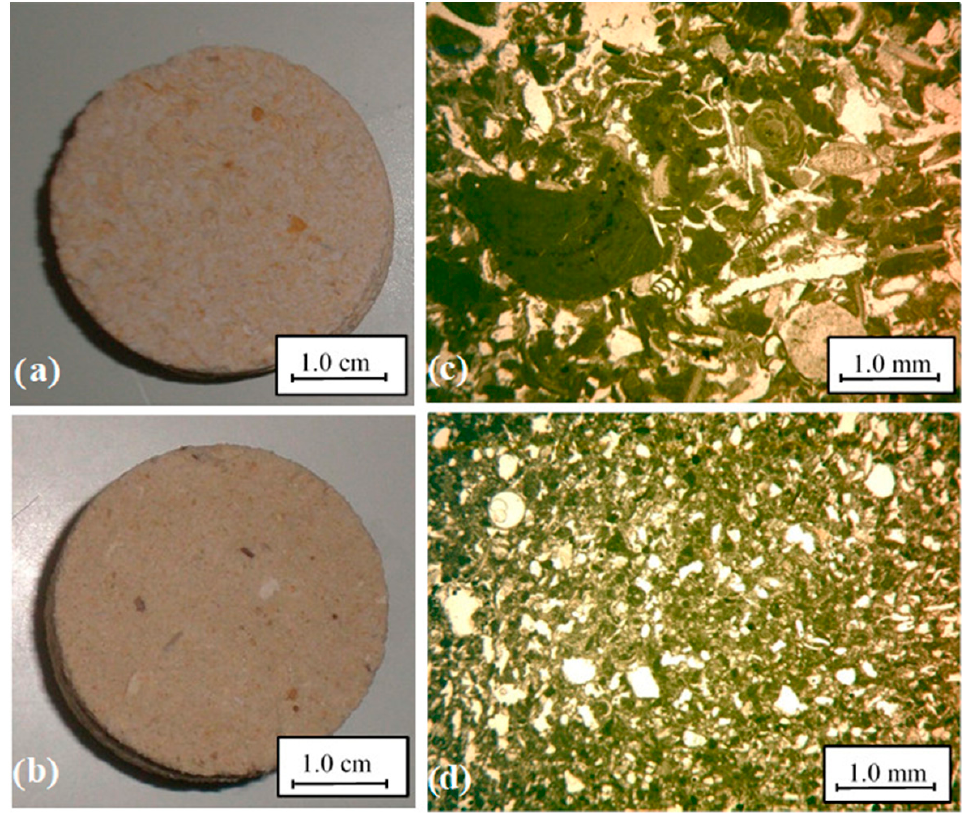
Figure 1. Macroscopic appearance of studied calcarenites: ( a ) lithotype C, medium-grained grain- stone, and ( b ) lithotype M, fine-grained packstone. Microscopic appearance in plane-polarized light of thin sections: ( c ) Lithotype C and ( d ) lithotype M.